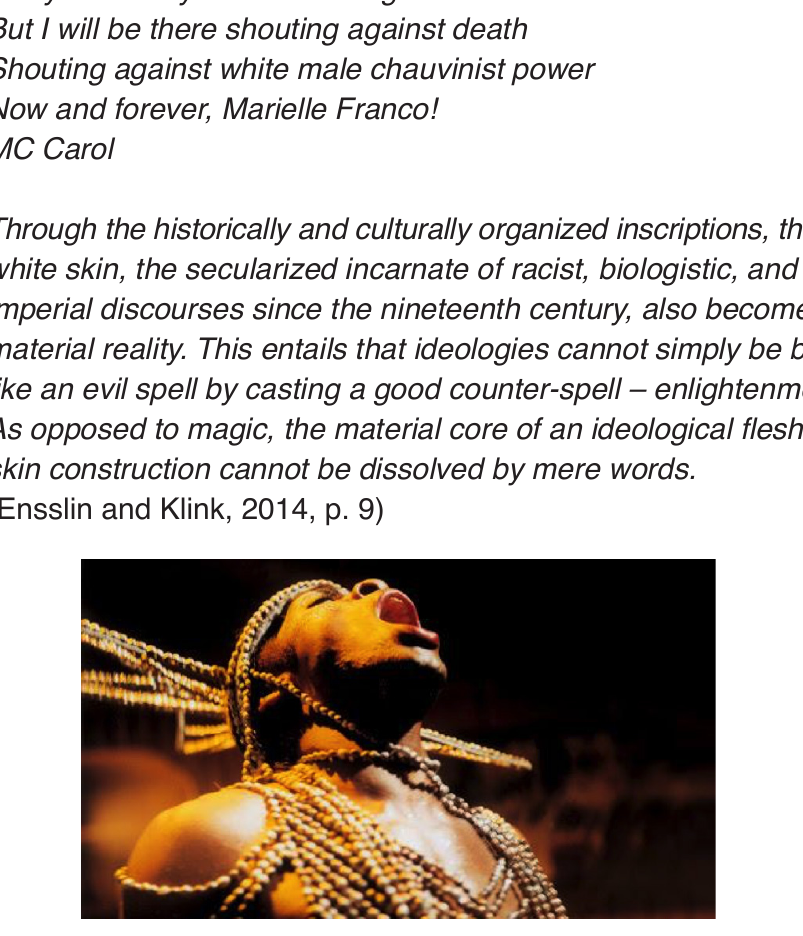
Figure 1: Madame Satã , Karim Ainouz ©